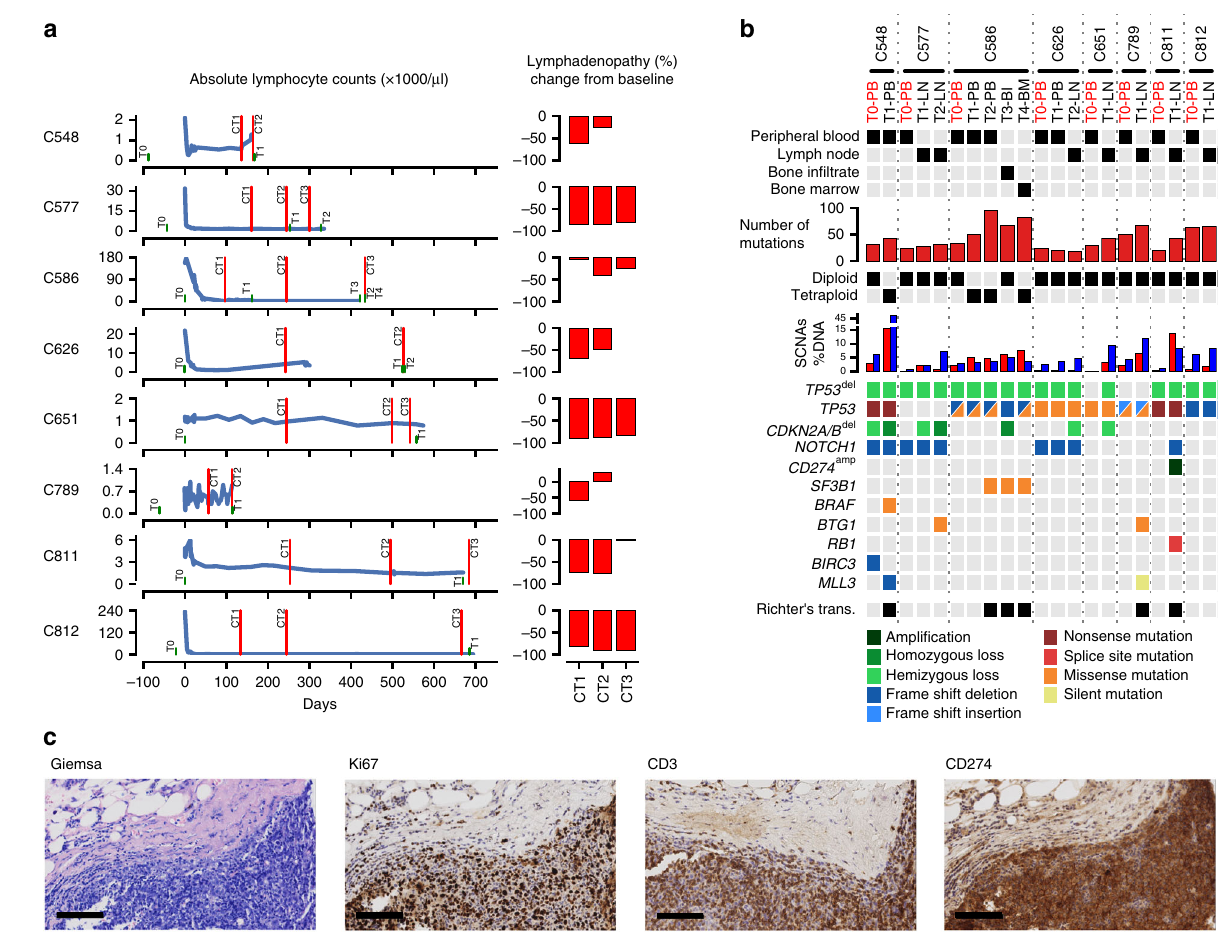
Fig. 1 Patient and their related matched pre-treatment and relapse samples characteristics. a Absolute lymphocyte counts and lymphadenopathy of the patients during venetoclax therapy. Day zero marks the start of the venetoclax treatment. Green lines show the time points of sample collection. Computer tomography (CT) scans for staging were performed at the time points marked by red lines. b Results from whole-exome sequencing are shown, including: number of somatic mutations, sample ploidy, percent of the genome undergoing copy number alterations (blue for losses and red for gains), and cancer- related gene mutations with pronounced clonal dynamics during therapy. Genomic alterations are annotated according to the color panel below the image. Sample type/compartment and the status if a patient has undergone a Richter ’ s transformation are additionally indicated. Pre-treatment samples (T0) are shown in red. c Giemsa, Ki67, CD3, and CD274 stains from lymph node material of patient C811 after relapse from venetoclax. High protein levels of CD274 are consistent with the genomic ampli fi cation of the locus containing CD274 . Scale bar, 100 µ